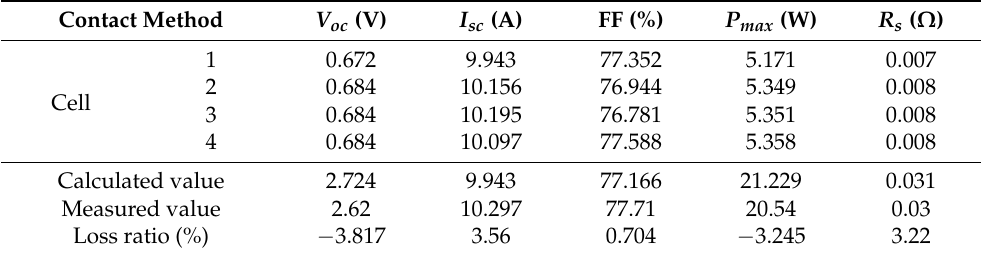
Table 2. Characteristics of the five-busbar tabbing module.